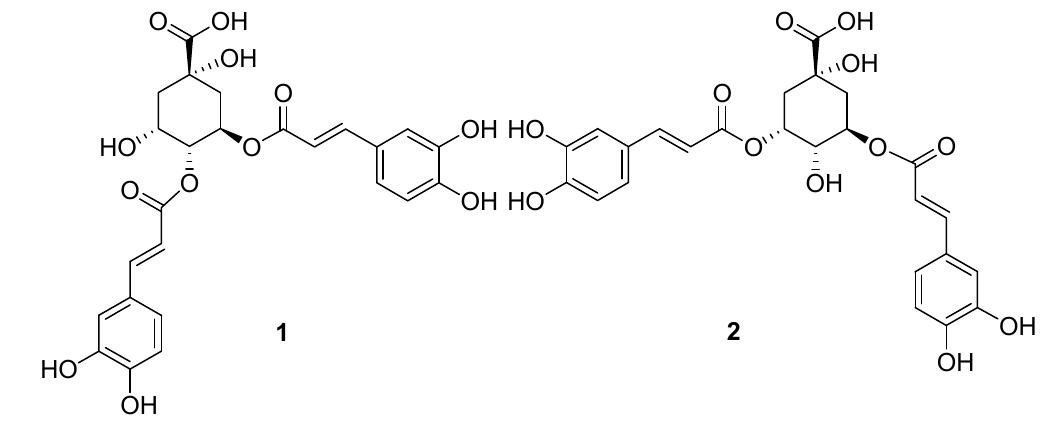
Figure 1. Structures of isochlorogenic acids B ( 1 ) and A ( 2 ).